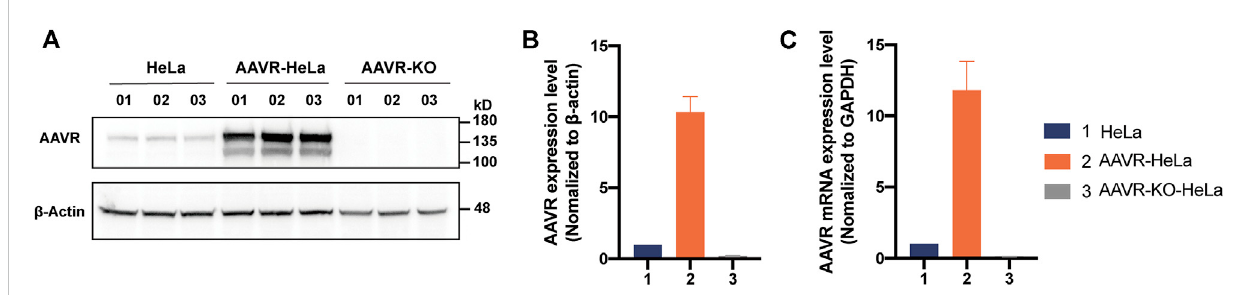
FIGURE 1 Construction of HeLa stable cells with overexpressed or knockout AAVR. The stable cells with overexpressed AAVR were constructed by infection with a lentiviral vector carrying the full-length AAVR gene. As a control, the stable cells with knockout AAVR were also constructed using the CRISPR/ Cas9 gene editing technology. The cells were seeded in triplicate onto six-well plates for protein and RNA extractions. (A) A representative Western blotting analysis of AAVR expression levels in HeLa, AAVR-HeLa and AAVR-KO-HeLa cells. (B) Fold change of AAVR protein expression levels in the threecelllines. (C) FoldchangeofmRNAexpressionlevelsinthethreecelllines.RT – qPCRwasusedforquanti fi cationandtheexpressionlevelofGAPDH was used for normalization ( n =